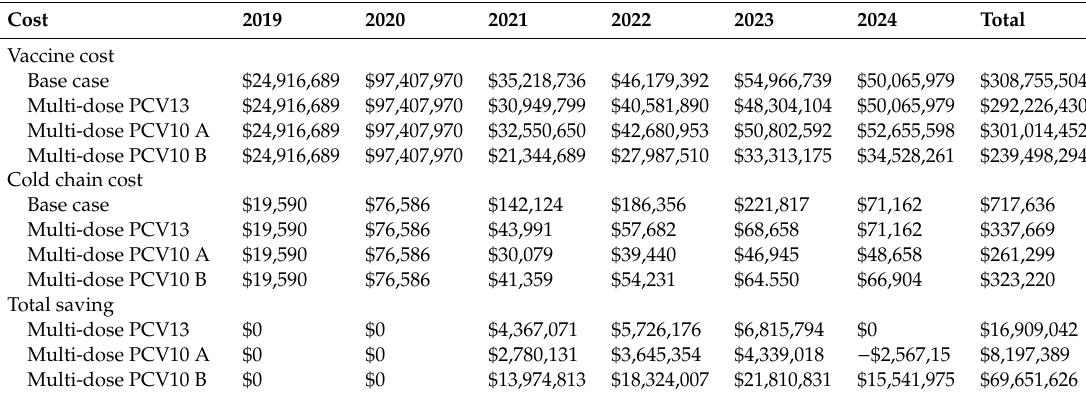
Table 5. Total potential saving on vaccine and cold chain cost among all